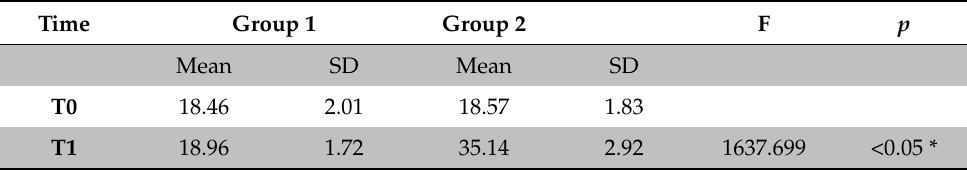
Table 2. Effect of the time * group interaction on the PRFQ test.